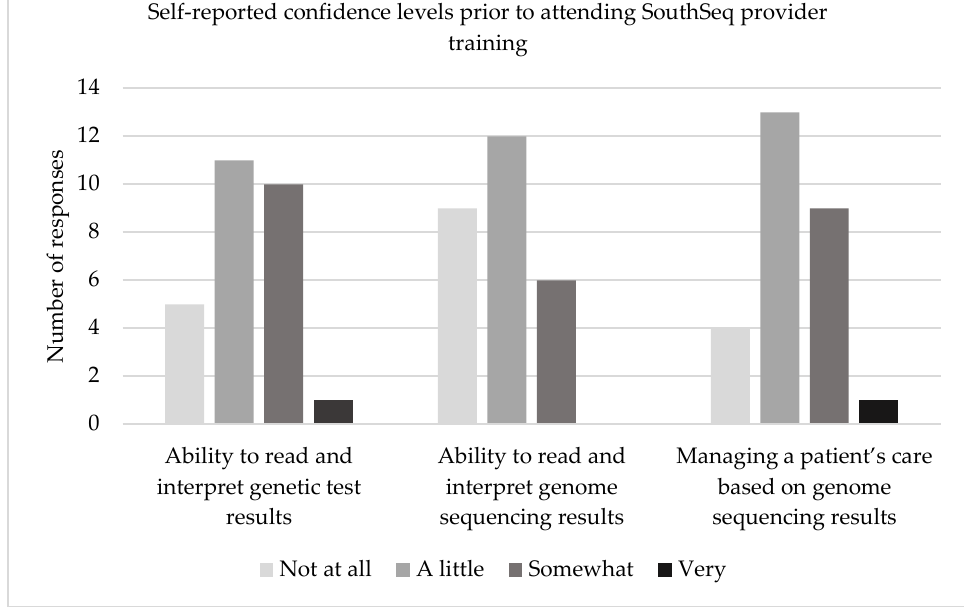
Figure 1. Baseline, self-reported confidence levels prior to attending SouthSeq provider training intervention related to ability to read and interpret genetic test results, ability to read and interpret genome sequencing results, and managing a patient’s care based on genome sequencing results.